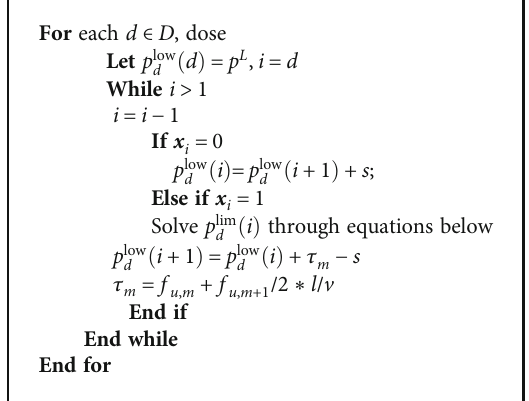
Algorithm 1: General p low